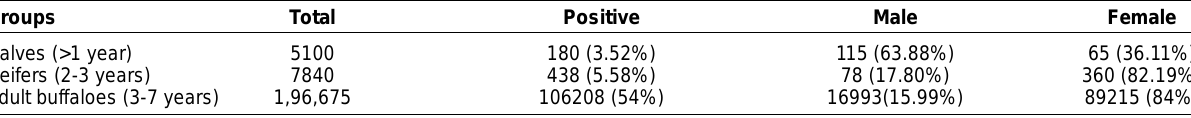
Table-2. Age-wise prevalence of hydatidosis in the respective groups.